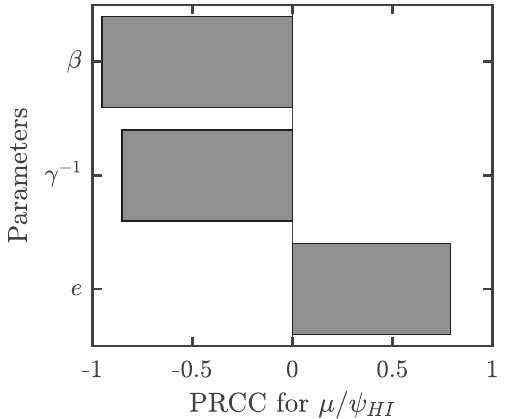
Fig 5. Sensitivity analysis of μ / ψ HI . Parameter values and ranges as specified in Table 1. For those values, μ / ψ HI � 0.61 meaning that to achieve herd immunity, the whole population at risk has to be vaccinated in about 61% of the average lifespan.